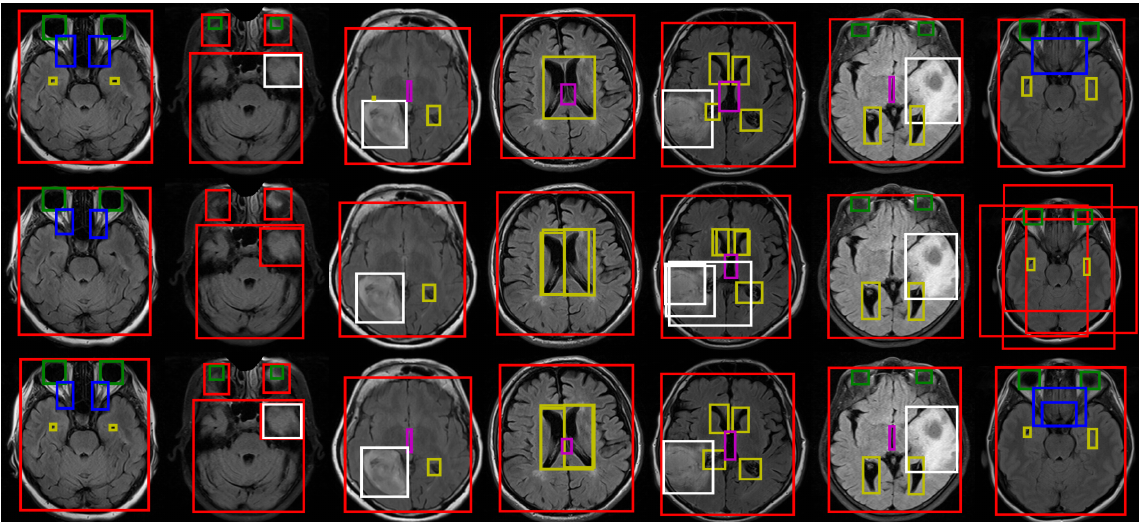
Figure 5. Example results for the best different models ensemble strategy on the FLAIR sequence. The first row shows the ground truth, the second row shows the best individual model, and the third row shows the ensemble results for the different best models. (red: ROI, green: eye, blue: optic nerve, yellow: lateral ventricle, magenta: third ventricle, white: whole